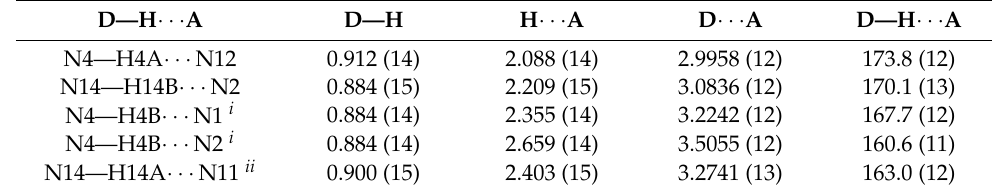
Table 2. Hydrogen bond geometry (Å, ◦ ).